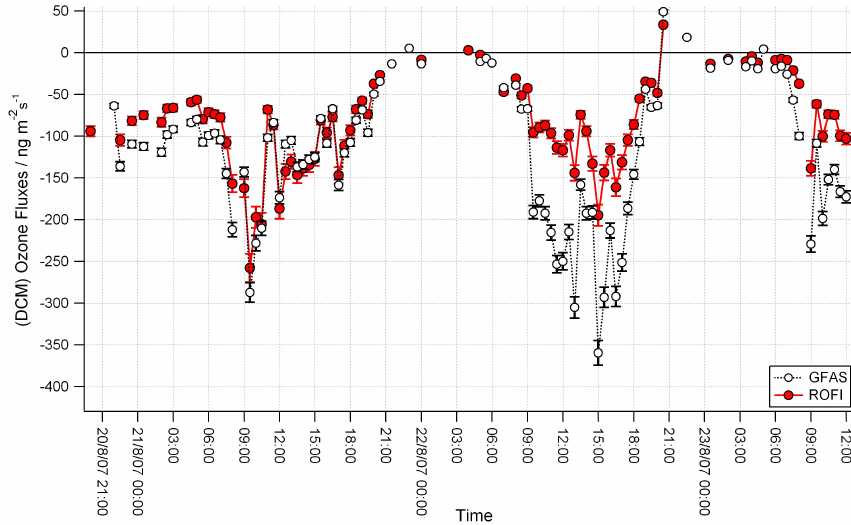
Fig. 5. GFAS and ROFI ozone fluxes with error bars for the calculation method DCM for 21 and 22 August 2007.